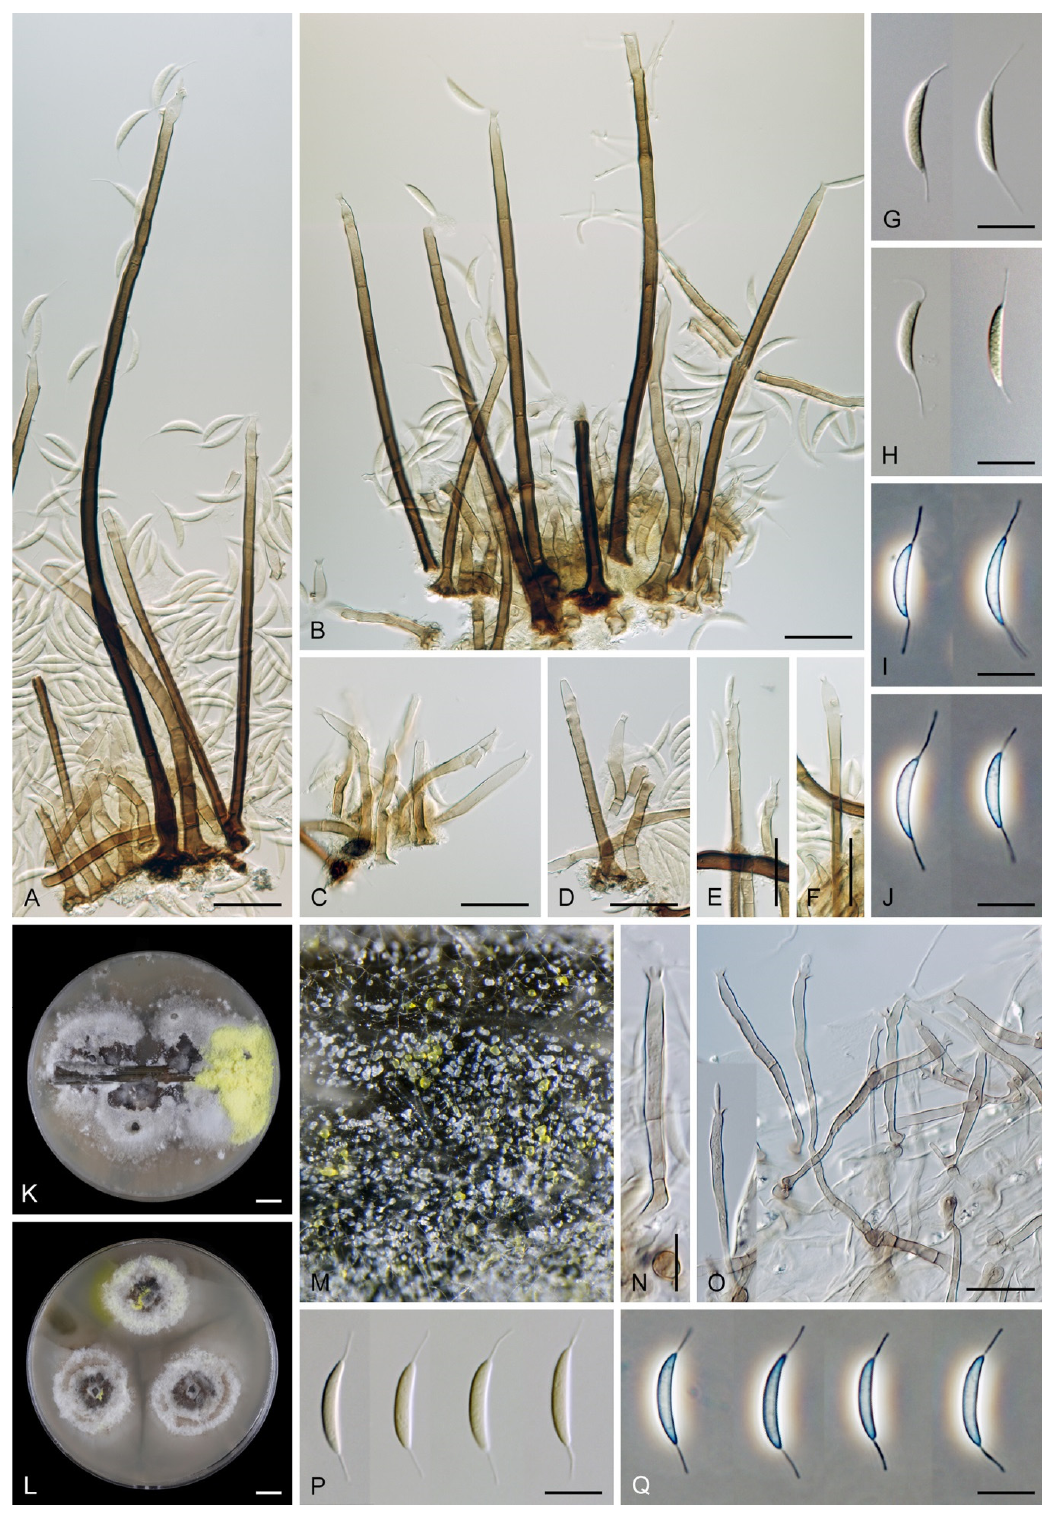
Figure 24. Codinaeella lutea . ( A – F , N , O ) Conidiophores ( G – J , P , Q ) conidia ( K – M ) colonies. Images: ( A – J ) from nature ( K , M – Q ) on stems of U. dioica on CMA after 8 weeks ( L ) on OA after 4 weeks ( A – L ) from CBS 146618 ex-type ( M – Q ) from CBS 624.77. Scale bars: ( A – F , O ) 20 μ m; ( K , L ) 1 cm; ( N , P , Q ) 10 μ m.